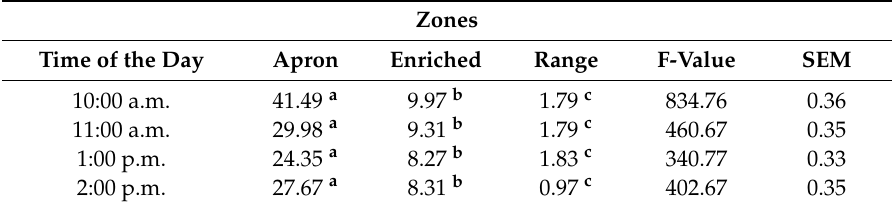
Table 4. Mean numbers of hens in the apron, enriched belt and outer range areas for all the time periods. Zones Time of the Day Apron Enriched Range F-Value SEM 10:00 a.m. 41.49 a 9.97 b 1.79 c 834.76 0.36 11:00 a.m. 29.98 a 9.31 b 1.79 c 460.67 0.35 1:00 p.m. 24.35 a 8.27 b 1.83 c 340.77 0.33 2:00 p.m. 27.67 a 8.31 b 0.97 c 402.67 0.35